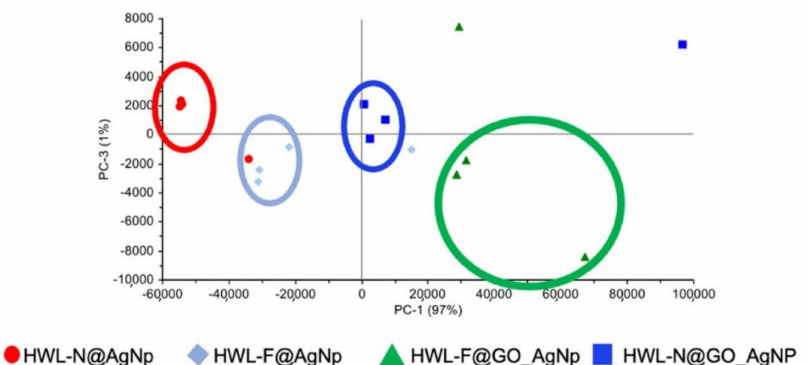
Figure 7. Scores plot of the whole collected SERS